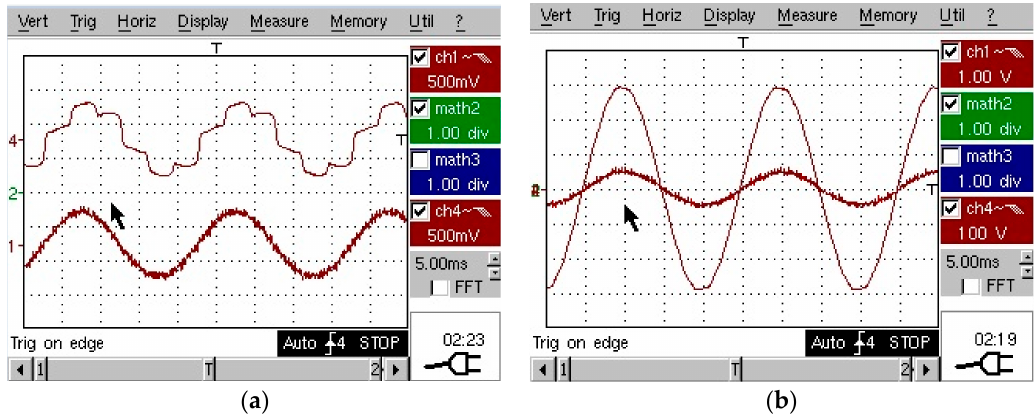
Figure 28. Oscillograms for the non-adaptive control at reduced load in steady state regime: ( a ) load current and supply current after compensation; ( b ) phase voltage and current after compensation.